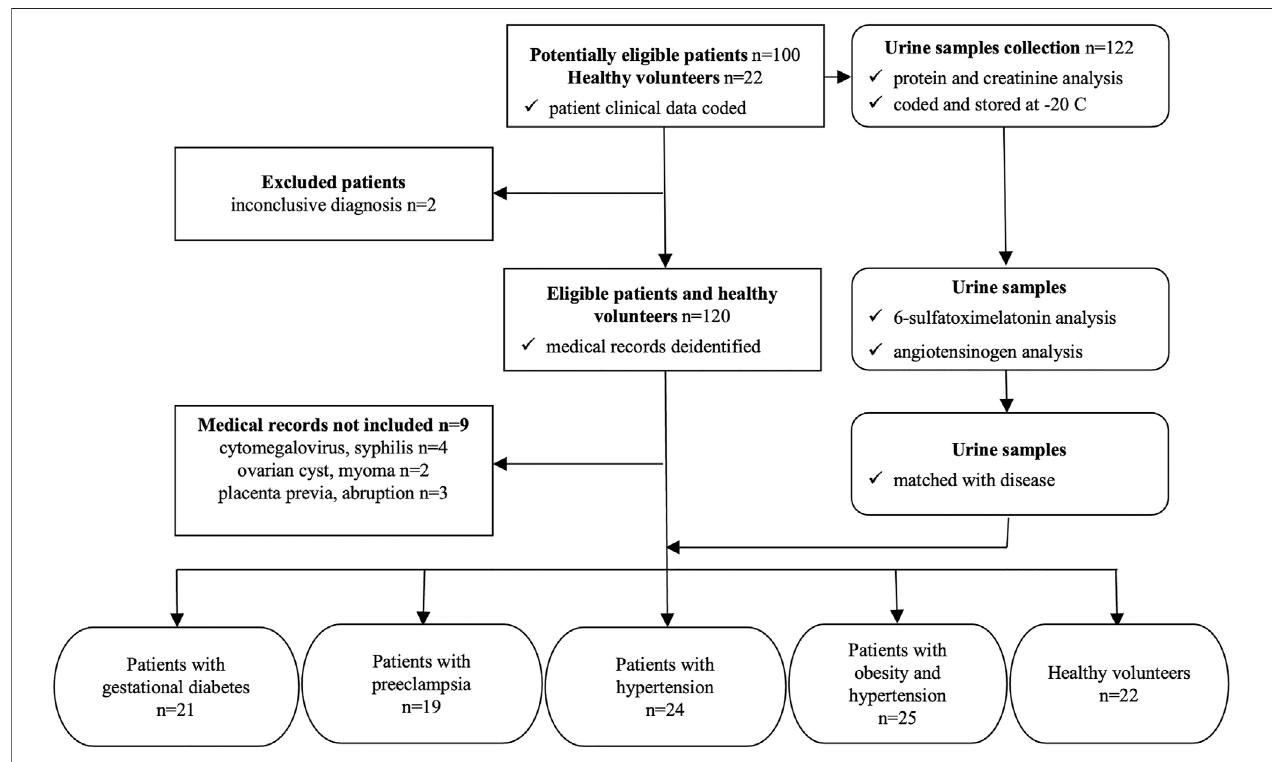
FIGURE 1 | STARD diagram to report fl ow of participants through the